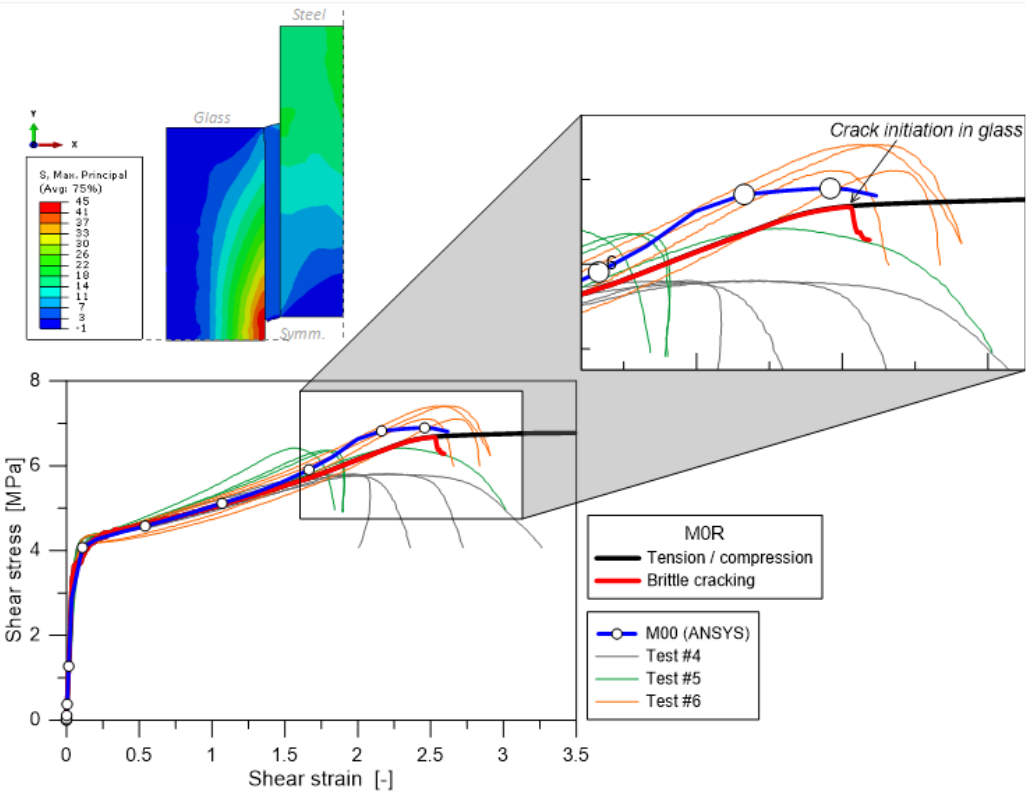
Fig. 4 Preliminary numerical assessment of the M0R model (ABAQUS), with respect to earlier experimental and FE studies (Pravdová et al., 2016; Machalická et al.,